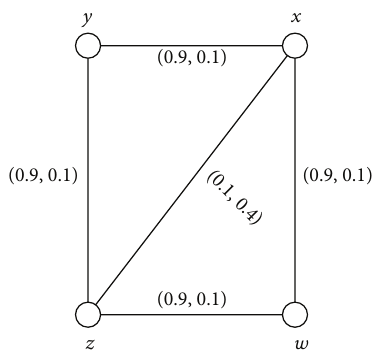
Figure 7: Connected intuitionistic fuzzy